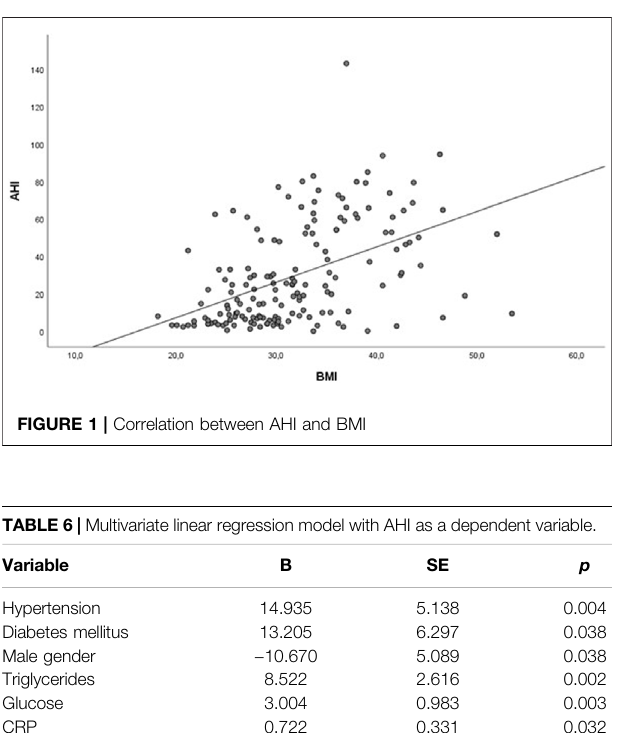
Average saturation